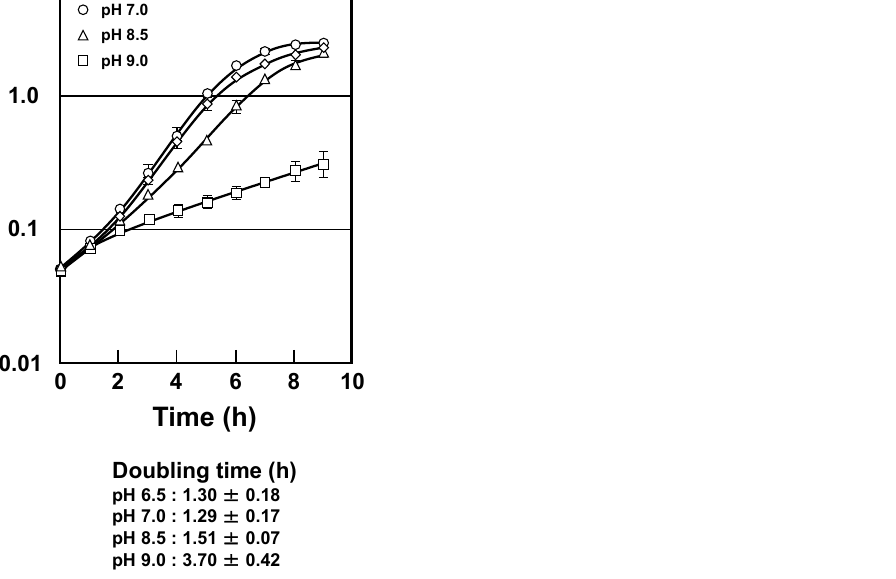
Figure 1. Cell growth of T. thermophilus HB8 grown at various pHs. Cell growth of T. thermophilus HB8 grown at pH 6.5 ( ◇ ), 7.0 ( ○ ), 8.5 ( △ ) or 9.0 ( □ ). The temperature was fixed at 70 °C. The results are shown as means ± standard errors, n = 3.